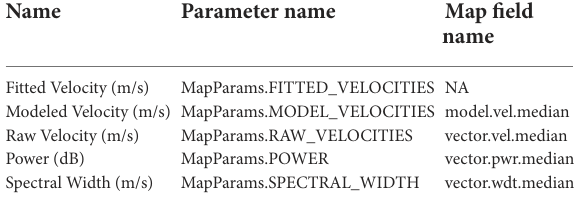
TABLE 2 Common parameters in a MAP file that can be plotted by